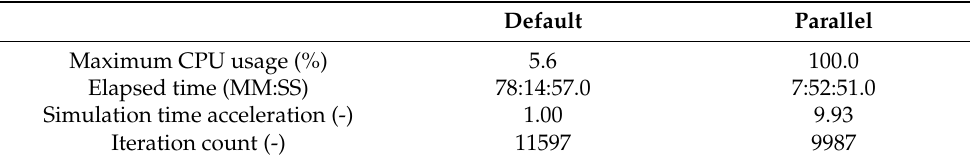
Table 3. Computational speed of the simulation with the Default and the Parallel method for the full number of mode